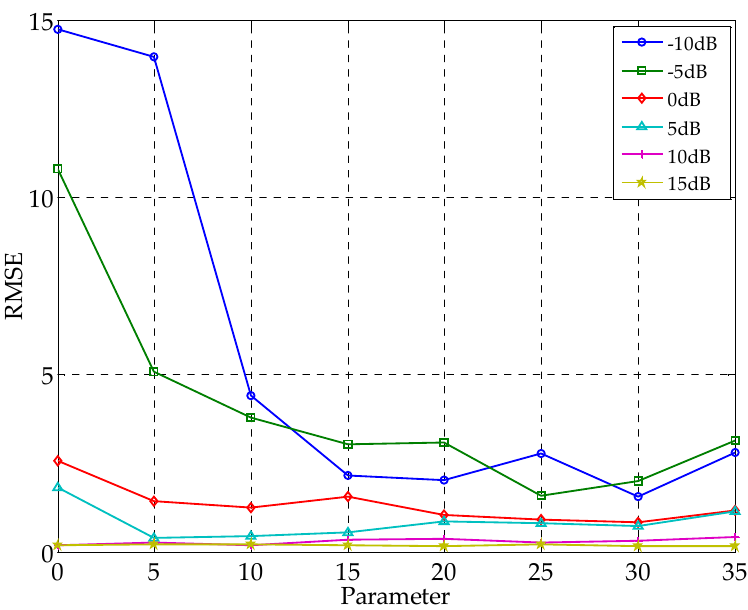
Figure 5. Root mean square error of CS-DOA estimation under different SNR and regularization parameters.